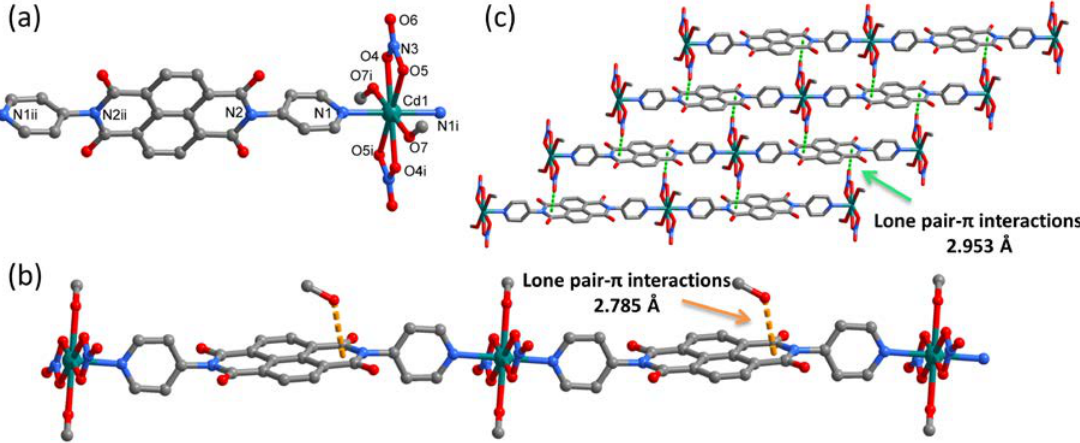
Figure 1. ( a ) Coordination environment of Cd 2+ in 1 , symmetry codes: (i) 2 – x, –y, 1 – z; (ii) –x, 2 – y, –z; ( b ) the lone pair- π interactions between NDI units and methanol ; and ( c ) the lone pair- π interactions extending the one-dimensional chains into a two-dimensional supramolecular network. All hydrogen atoms are omitted for clarity.